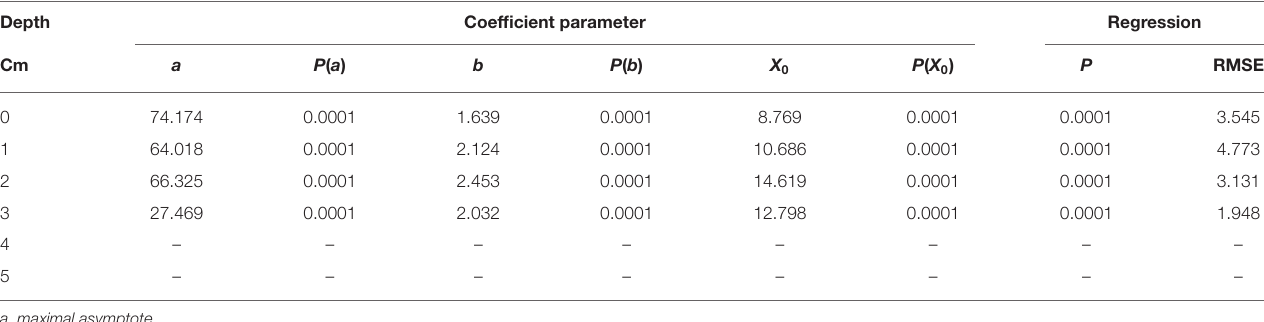
TABLE 2 | The coefficient of three parameters log-logistic equation fitted to describe the emergence dynamics of Parthenium hysterophorus seeds sown in different soil depths. Depth Coefficient parameter